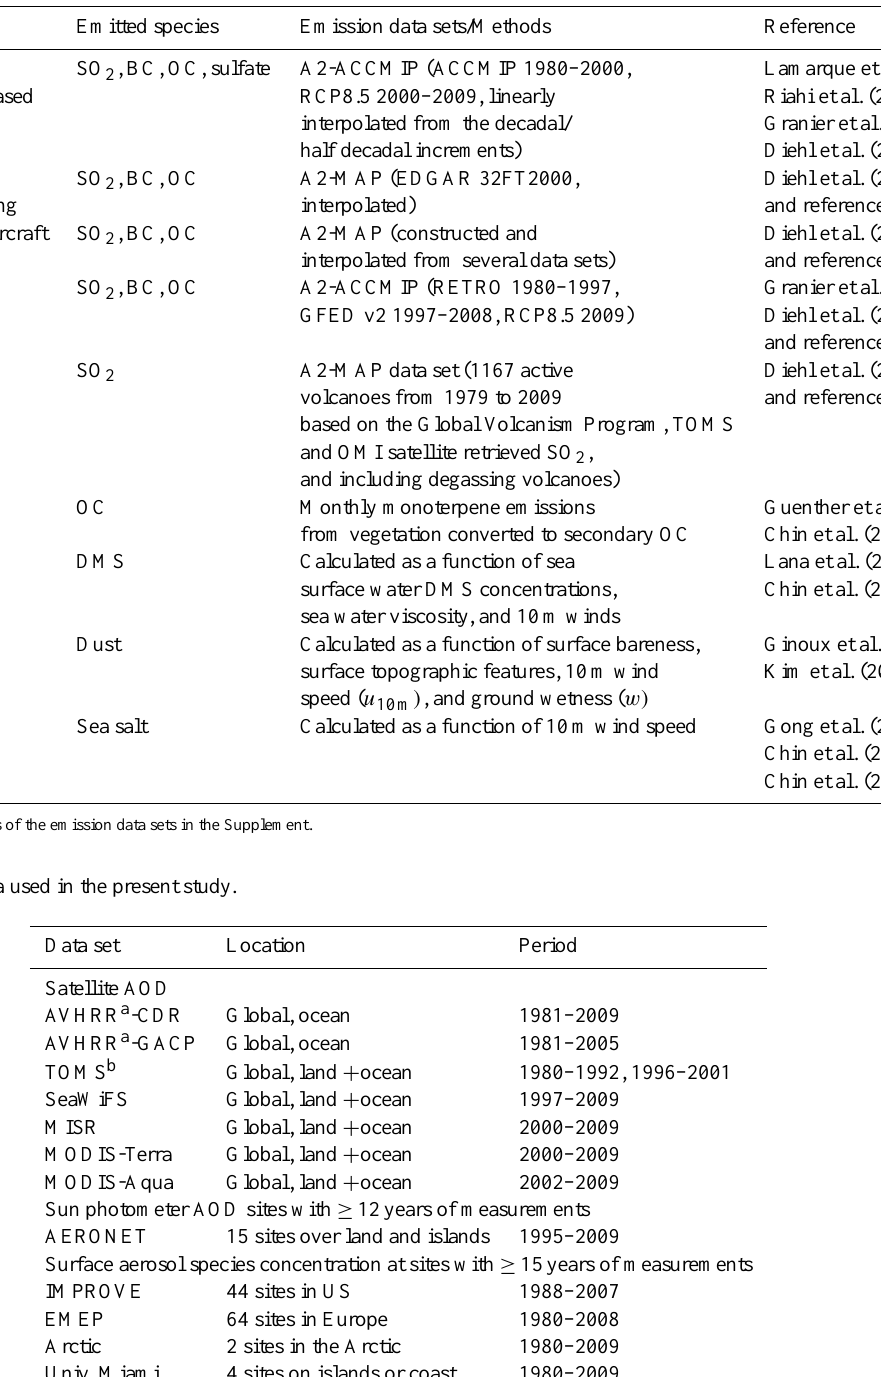
Table 2. Emissions used in the present study ∗ .